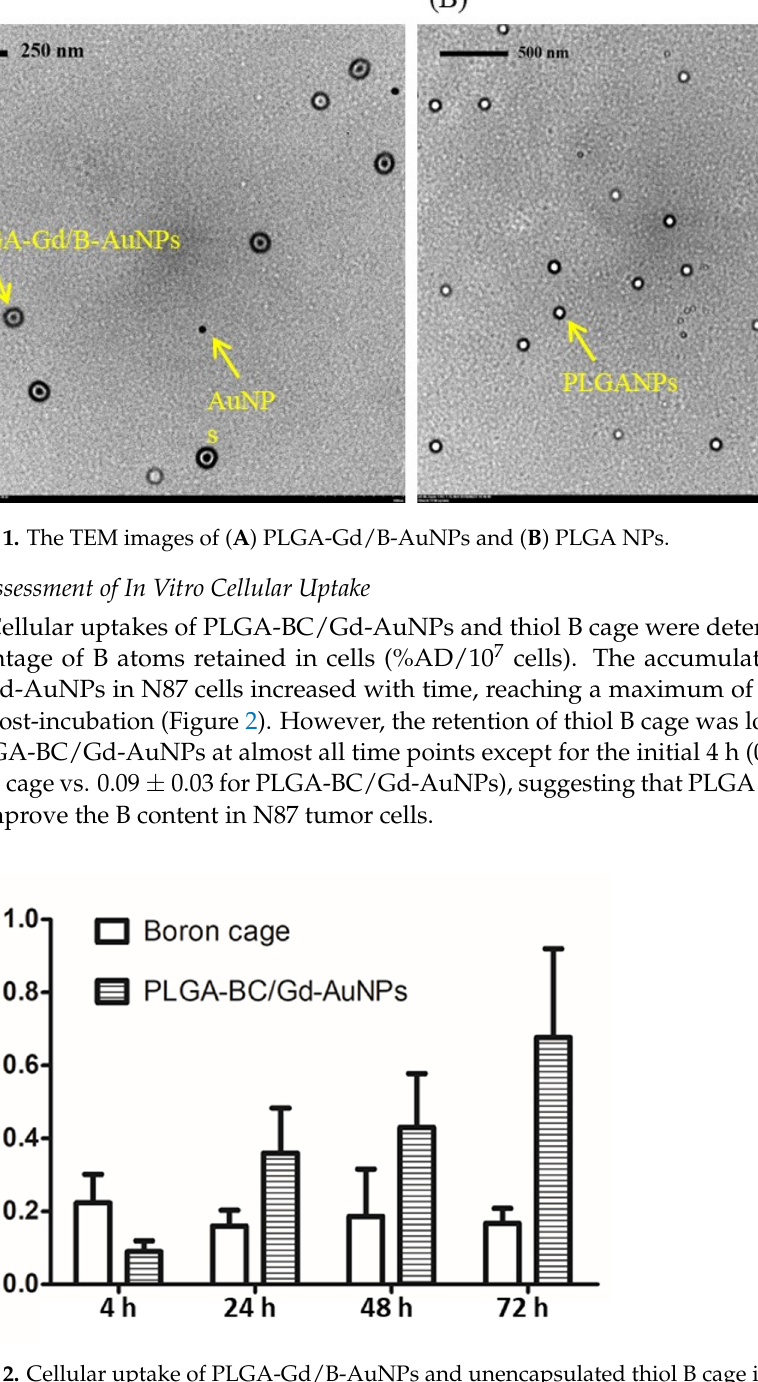
Figure 2. Cellular uptake of PLGA-Gd/B-AuNPs and unencapsulated thiol B cage in N87 cells at 4, 24, 48 and 72 h after incubation. T1W MR images of different concentrations of Gd in NPs are displayed in Figure